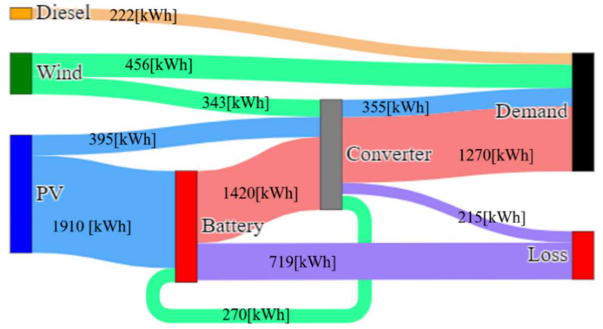
Figure 24. Annual energy balance in the proposed microgrid.